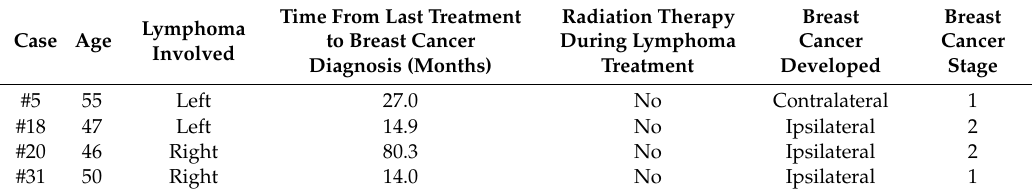
Table 3. Subsequent breast cancer in